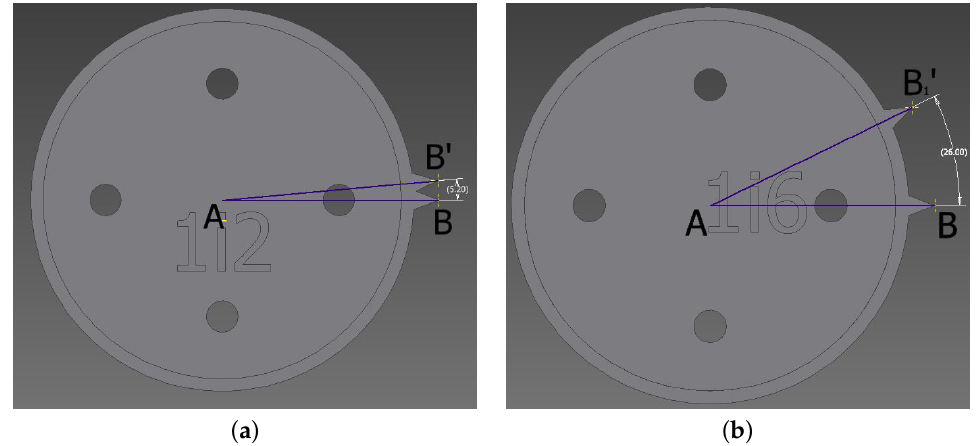
Figure 4. Re-excitation discs: ( a ) second excitation after 12 ms, maximum; ( b ) second excitation after 70 ms,